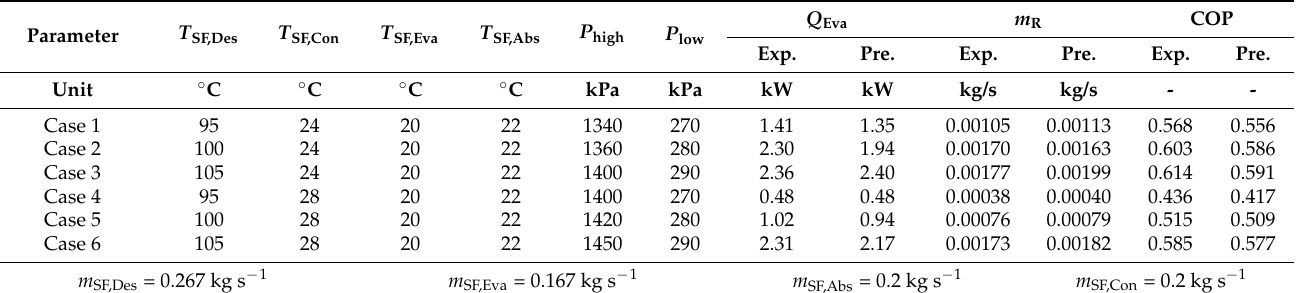
Table 2. Comparison of the numerical model results with the experimental data of Jim é nez-Garc í a